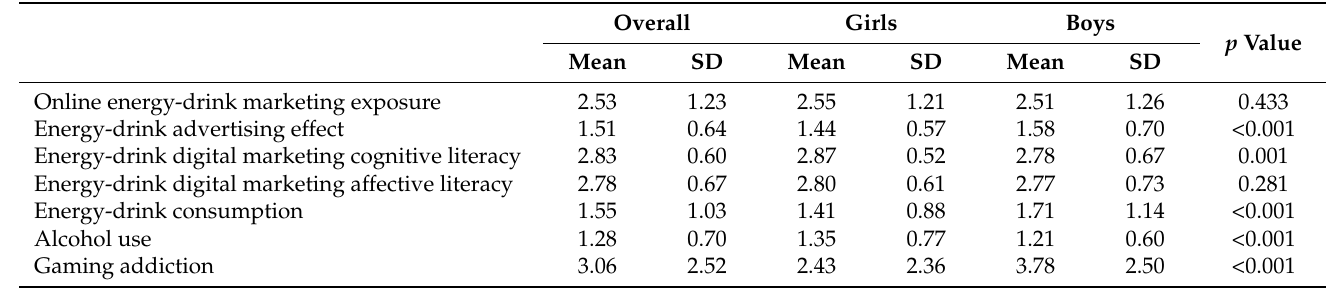
Table 1. Gender differences in energy-drink consumption and related